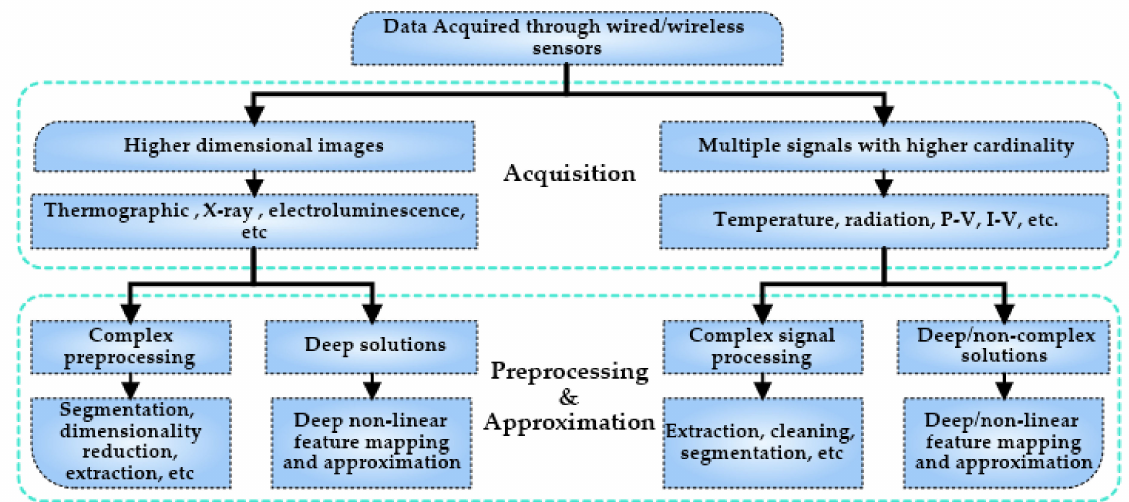
Figure 8. Classification of sensor types used for PV system